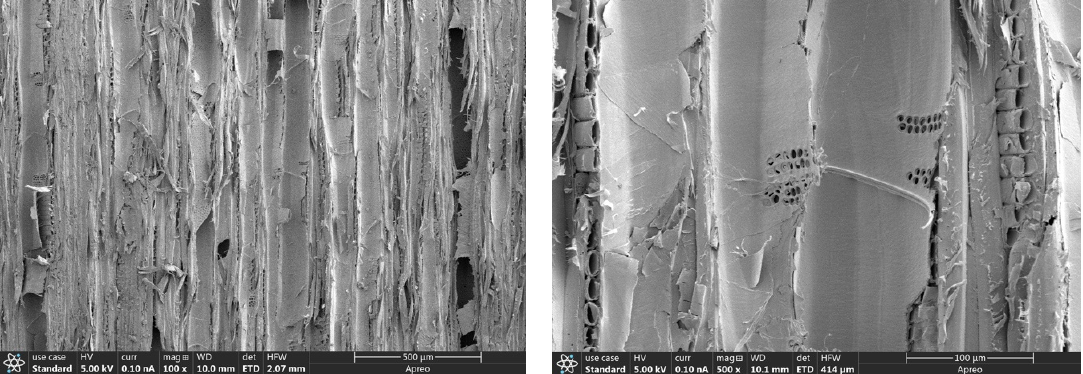
Figure 9. The internal morphology of the undried blocks.